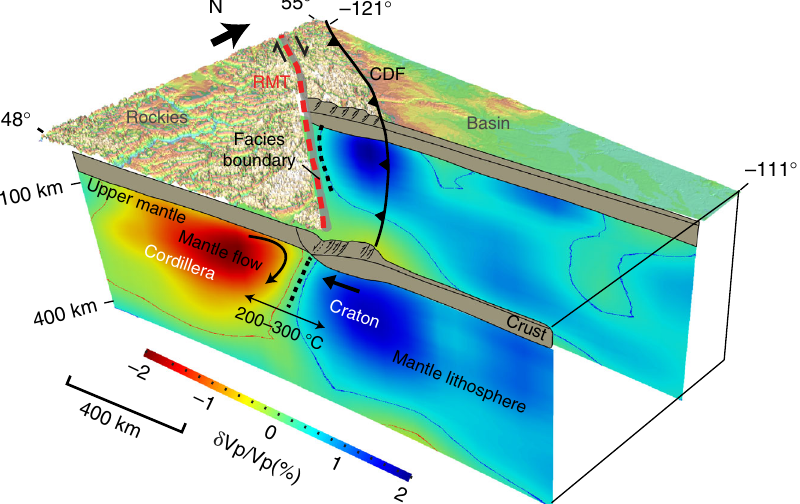
Fig. 4 A 3-dimensional perspective of the Cordillera – craton boundary. The pro fi le in the south is dominated by margin-perpendicular displacement whereas the northern pro fi le is characterized by strike-slip motion. The Rocky Mountain Trench and Cordilleran Deformation Front are shown by the red dashed and black barbed lines, respectively. The surface facies boundary is shaded in gray and the mantle boundary is indicated by the black dashed line on the cross-